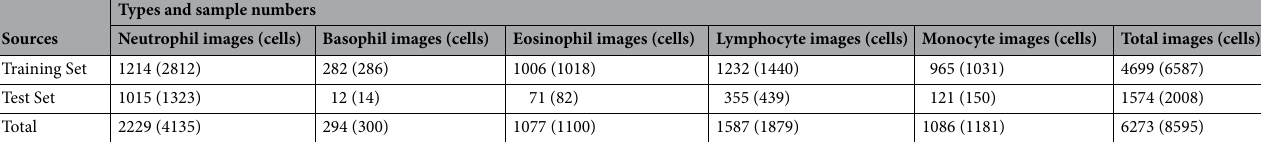
Table 1. The number of images and leukocytes in the created dataset.